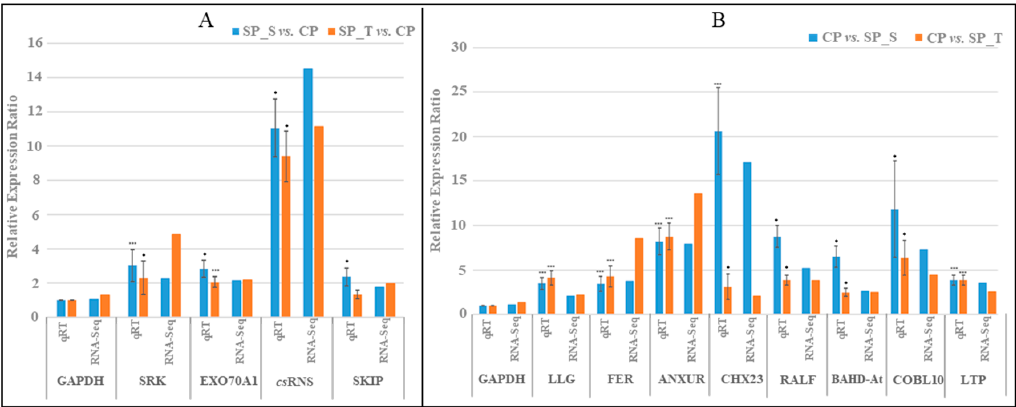
Figure 4. qRT-PCR validation of RNA-seq data using GAPDH as internal control. ( A ) Significantly upregulated SI related transcripts in SP pistils. ( B ) Significantly upregulated fertilization related transcripts in CP pistils. The bar represents standard deviation (SD) of relative expression for three replicated, and significance level is represented as stars: p -values (0.001, 0.01, 0.05) <=> symbols (“***”, “**”, “*”).